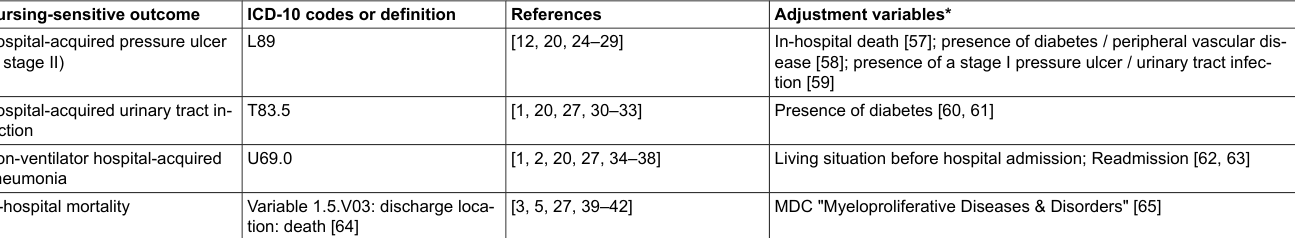
Table 1: Nursing-sensitive outcomes of interest. Nursing-sensitive